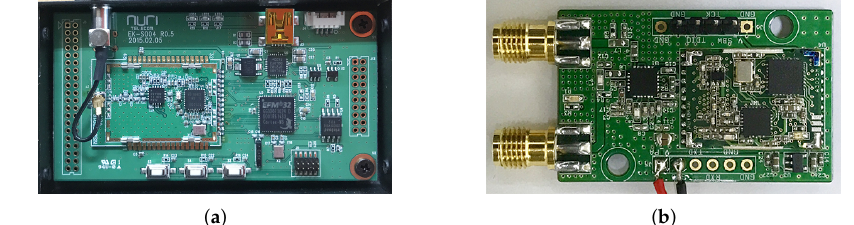
Figure 9. Wi-SUN modems for the Wi-SUN measurement. ( a ) Wi-SUN Modem 1 (Nuritelecom Co. Ltd.). ( b ) Wi-SUN Modem 2 (Automan Co. Ltd.).